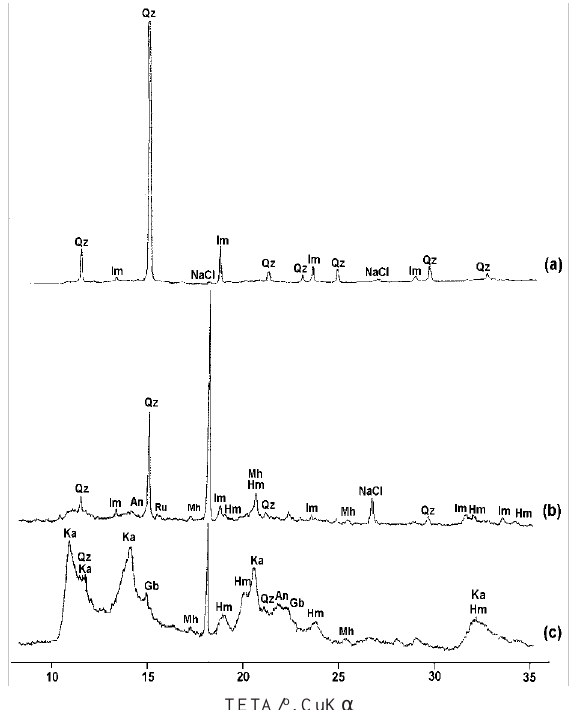
Figura 1. DRX das frações areia (a), silte (b) e argila (c) referentes à amostra coletada a 2 m de profundidade. Radiação K ααααα Co. An = anatásio; Ka = argilomineral do grupo da caulinita; Gb = gibbsita; Mh = maghemita; Hm = hematita; Qz = quartzo; Im = ilmenita; Ru = rutilo; NaCl - cloreto de